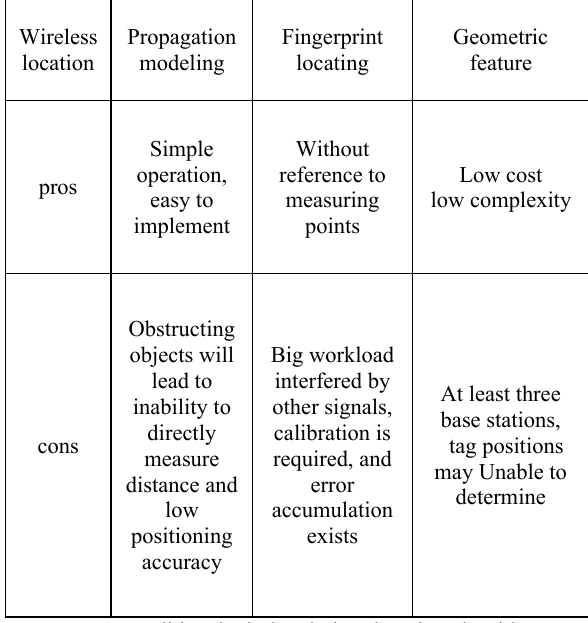
Table 1 . Traditional wireless indoor location